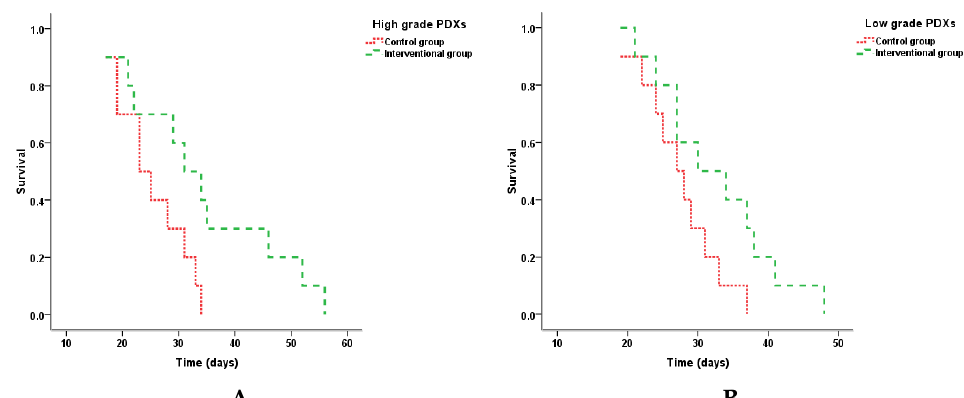
Figure 3. Kaplan–Meier plots for cumulative survival of animals, PDX carriers, in high- ( A ) and low- ( B ) grade NMIBC control and interventional groups.